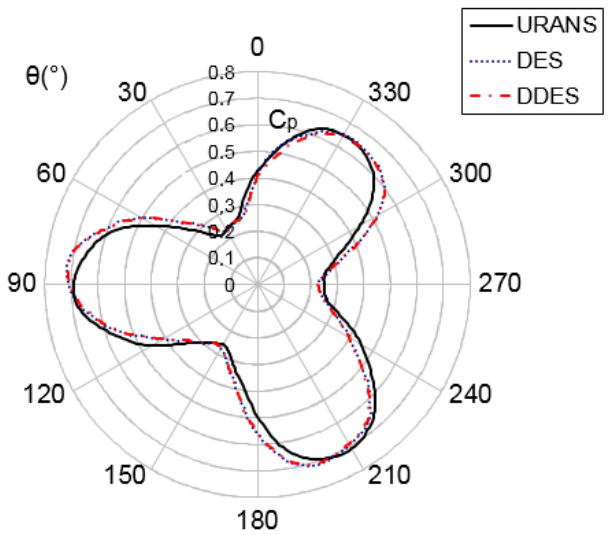
Figure 9. Average power coefficient for λ = 1, λ = 2, λ = 2.5. Numerical results vs. experiments.